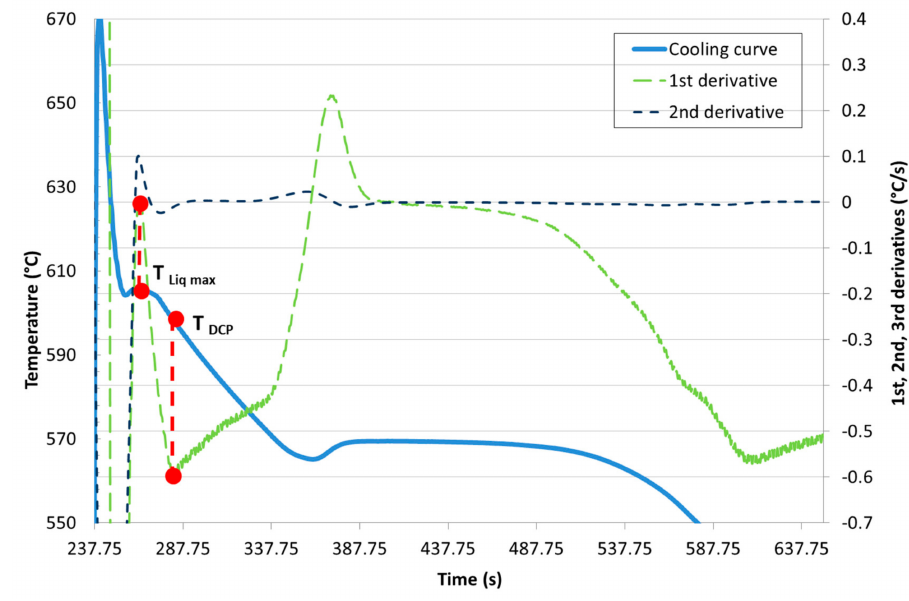
Figure 2. Method 2: the first minimum of the dT/dt curve after T liq max